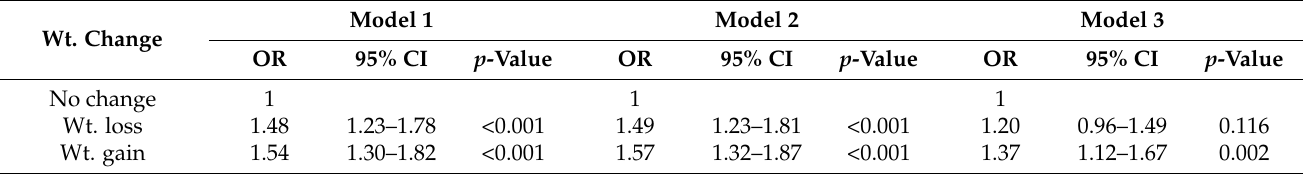
Table 2. Association between weight change and knee pain: results of multiple logistic regression.